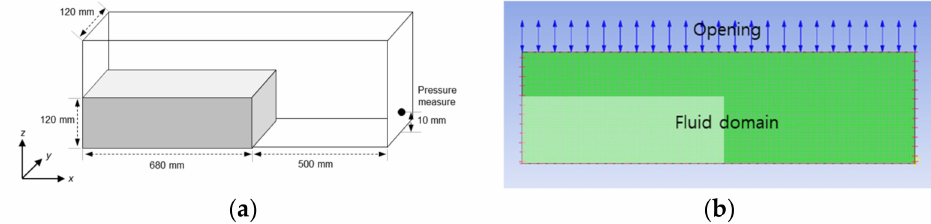
Figure 1. Configuration of experiment ( a ) and CFD model ( b ) for dam-breaking problem [27].